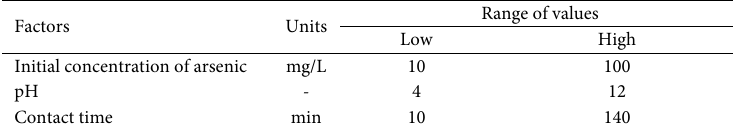
Table 1. Range of values for each